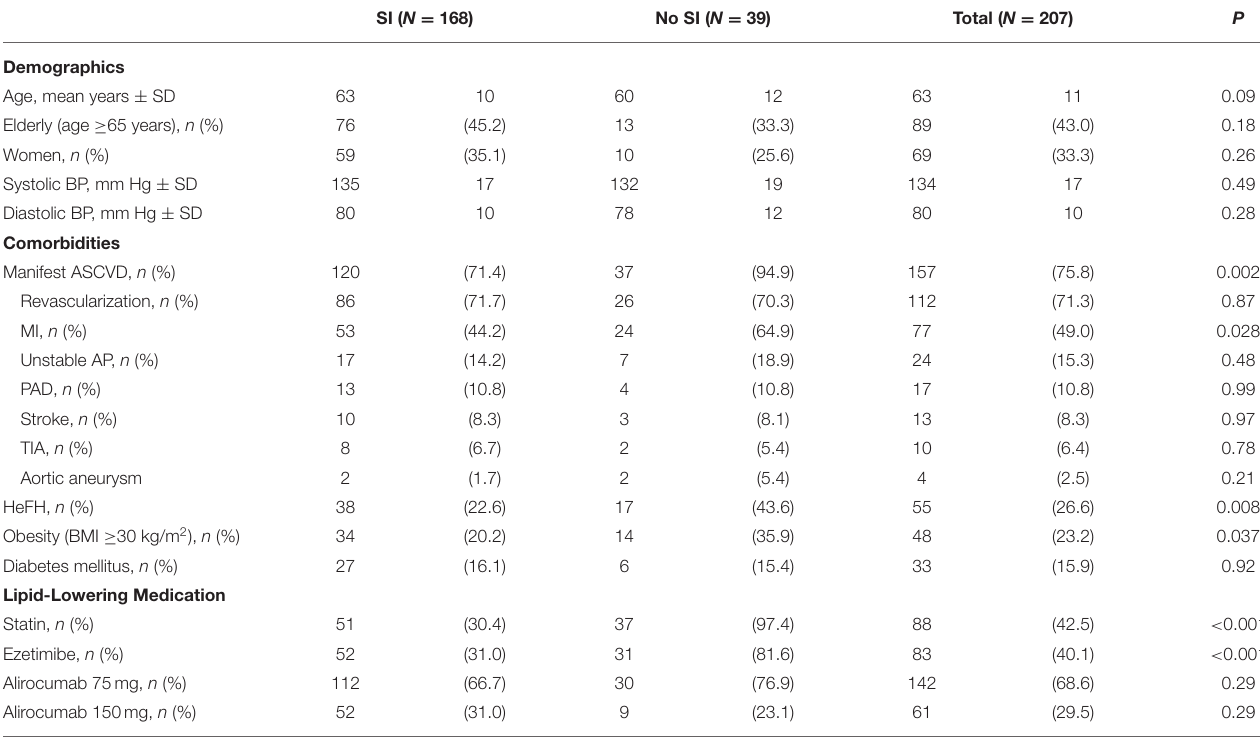
TABLE 1 | Demographics, comorbidities, and lipid-lowering medication according to the presence of statin intolerance. SI ( N = 168) No SI ( N = 39) Total ( N = 207)